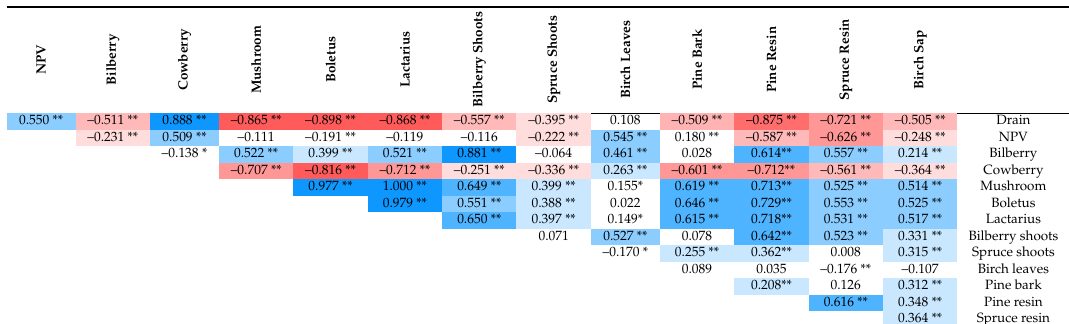
Table 4. Correlation matrix among timber drain and net present value (NPV) and yields of non-wood forest products obtained by following a total of 214 holding-level forest plans in pine-dominated forest holding.